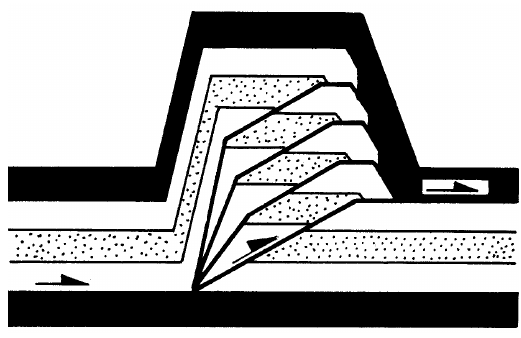
Fig. 1 – An antiformal stack according to McClay